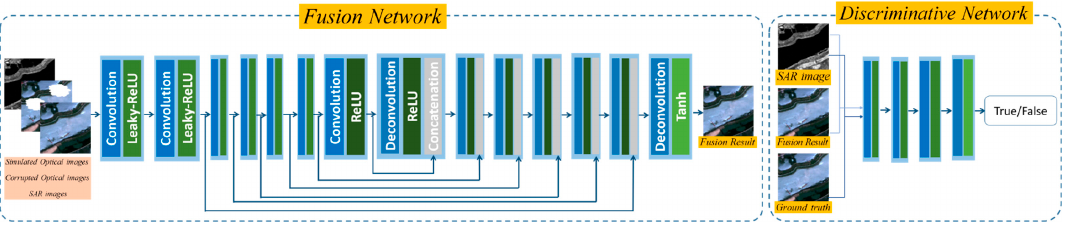
Figure 3. Structure of the fusion network.